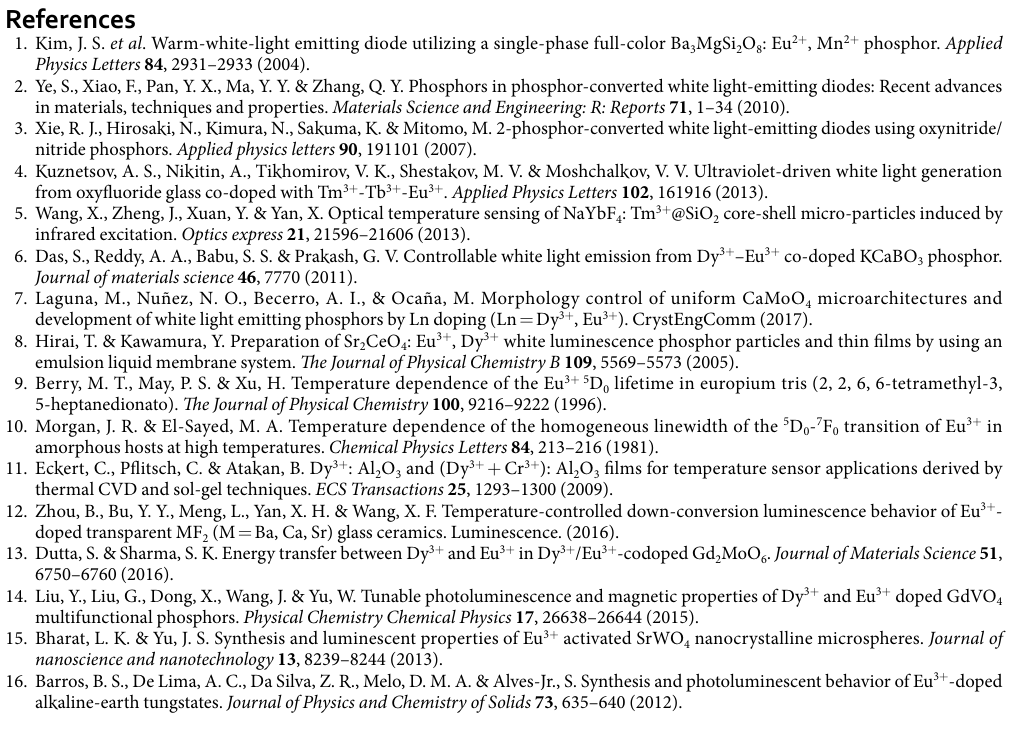
The photoluminescence excitation (PLE) spectra are recorded by a Pjoton Technology International (PTI, USA) fluorimeter with a 60 W Xe-arc lamp as the excitation light source at room temperature. The photoluminescence (PL) spectra and decay lifetimes are collected by a 266 nm-pulsed laser with a pulse width of 5 ns and a repetition rate of 10 Hz (Spectron Laser Sys. SL802G).